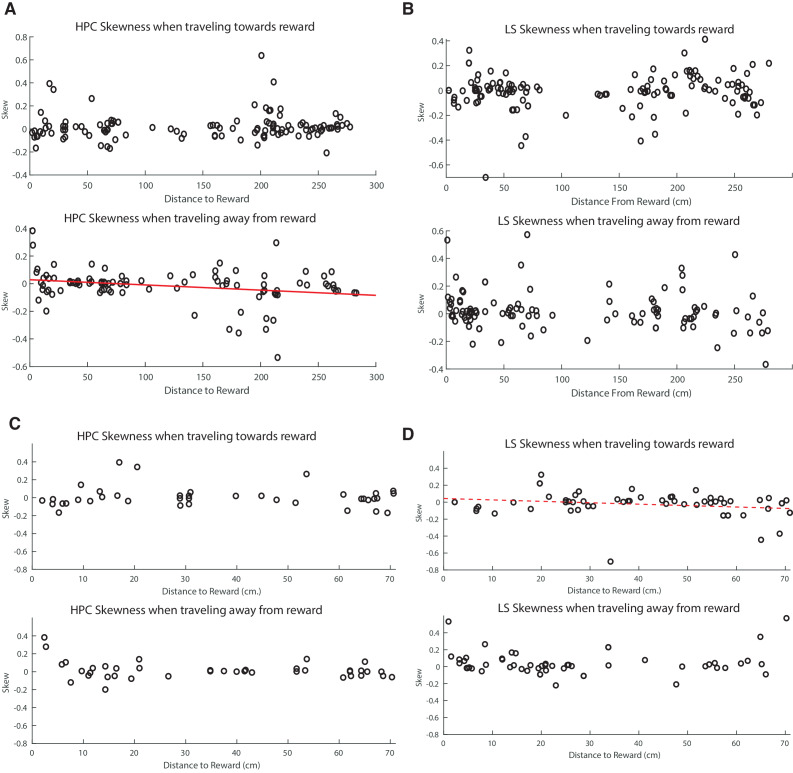
Skew versus distance to reward site across the whole track.(A) Top: Scatter plot of skewness in HPC place cells versus distance to reward when traveling to reward. Bottom: Scatter plot of skewness in HPC place cells versus distance to reward when traveling away from reward. The linear correlation was significant (F statistic(1,92)=7.01, p<0.01, r2=0.07). (B) Same as A but in the LS. Neither linear correlation was significant (C) Same as A but only reward proximate HPC fields displayed. No significant linear correlations. (D) Same as B but only reward proximate LS fields displayed. Traveling to reward, the correlation neared significance (F statistic(1,60)=3.18, p=0.079, r2=0.03).